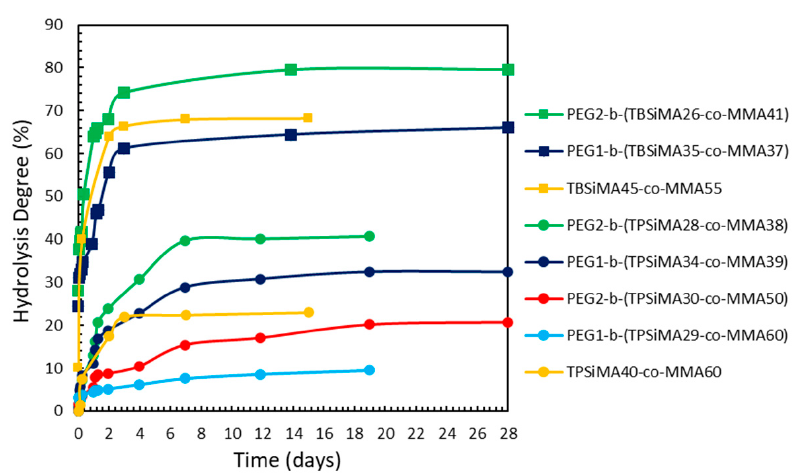
Figure 4. Hydrolysis degree of TBSiMA- and TPSiMA-based copolymers in THF-d8 with pH 10